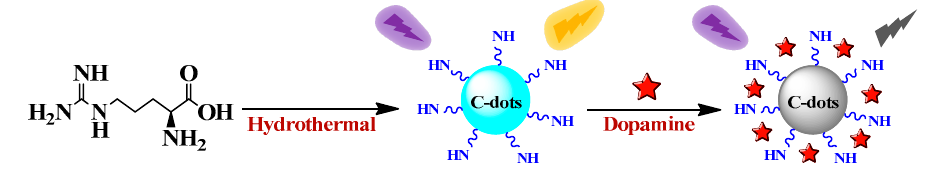
Scheme 1. The synthetic strategy for C-dots and the principle of DA